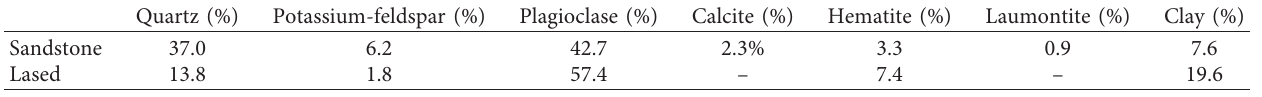
Figure 3: Surface morphologies of sandstone by fiber laser irradiation. (a) Full view of laser perforation. (b) Nonirradiated surface. (c) Holes in glazed layer. (d) Cracks on the edge of perforation. Table 5: Compositions of sandstone before and after laser